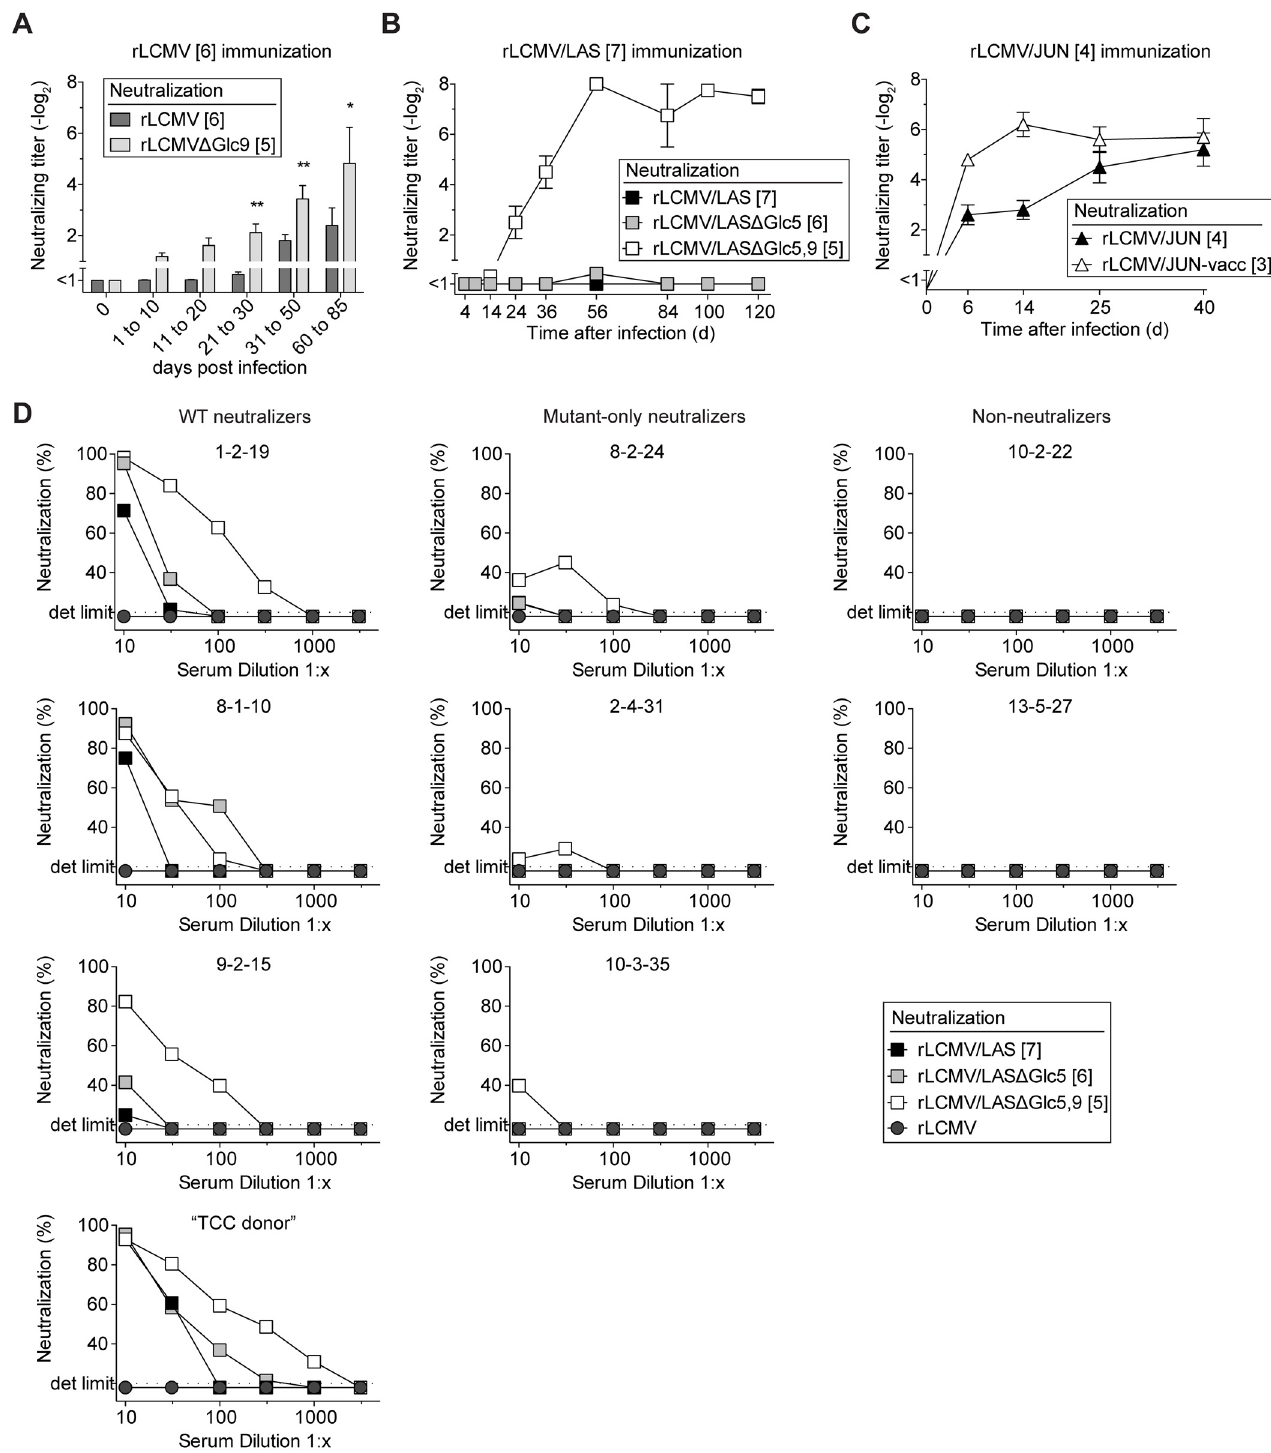
Fig 3. WT virus-induced antibody responses neutralize preferentially GP-1 variants that lack specific glycans. (A-C) We infected C57BL/6 mice i.v. with rLCMV (wt GP, 2x10 5 -4x10 6 PFU, A), rLCMV/LAS (5x10 5 PFU, B) or rLCMV/JUN (2x10 5 PFU, C). Serum samples were collected during the indicated time windows after infection and were tested for their neutralizing capacity against the respective immunizing viruses or their partially deglycosylated variants. (A) Bars represent the mean ± SEM of 23 – 39 mice per group up to day 50 and of 8 mice per group between days 60 – 85. A two-way ANOVA followed by Bonferroni ’ s post-test for multiple comparisons was performed. * p < 0.05, ** p < 0.01. Combined data from six independent experiments are